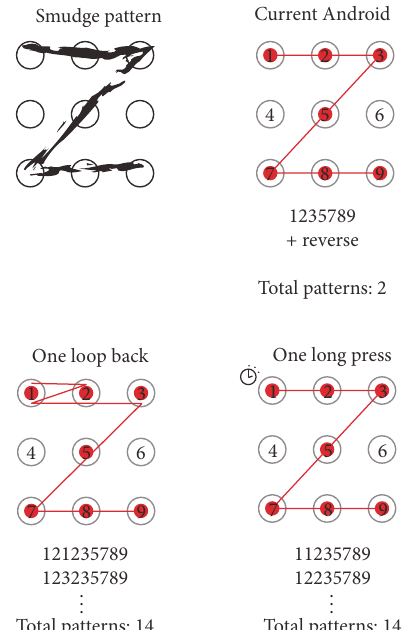
Figure 3: Additional lock code ambiguity is introduced by a single reselected or duplicated node selection based on a start smudge pattern. The red line visualizes the lock path defining the respective pattern.